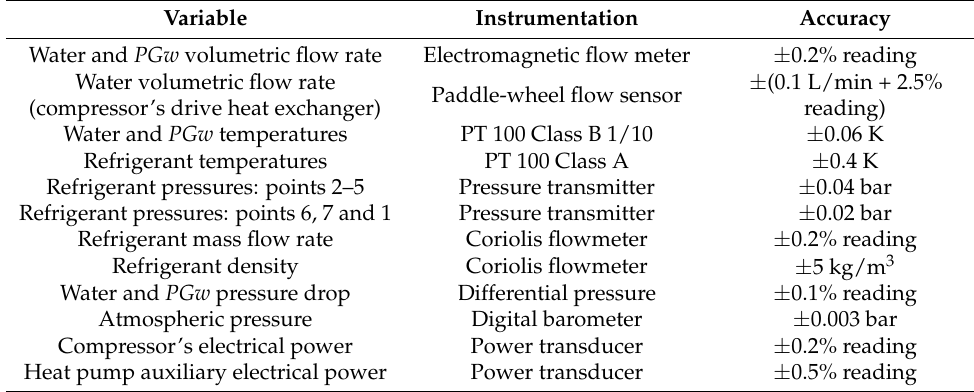
Table 1. Types of sensors and